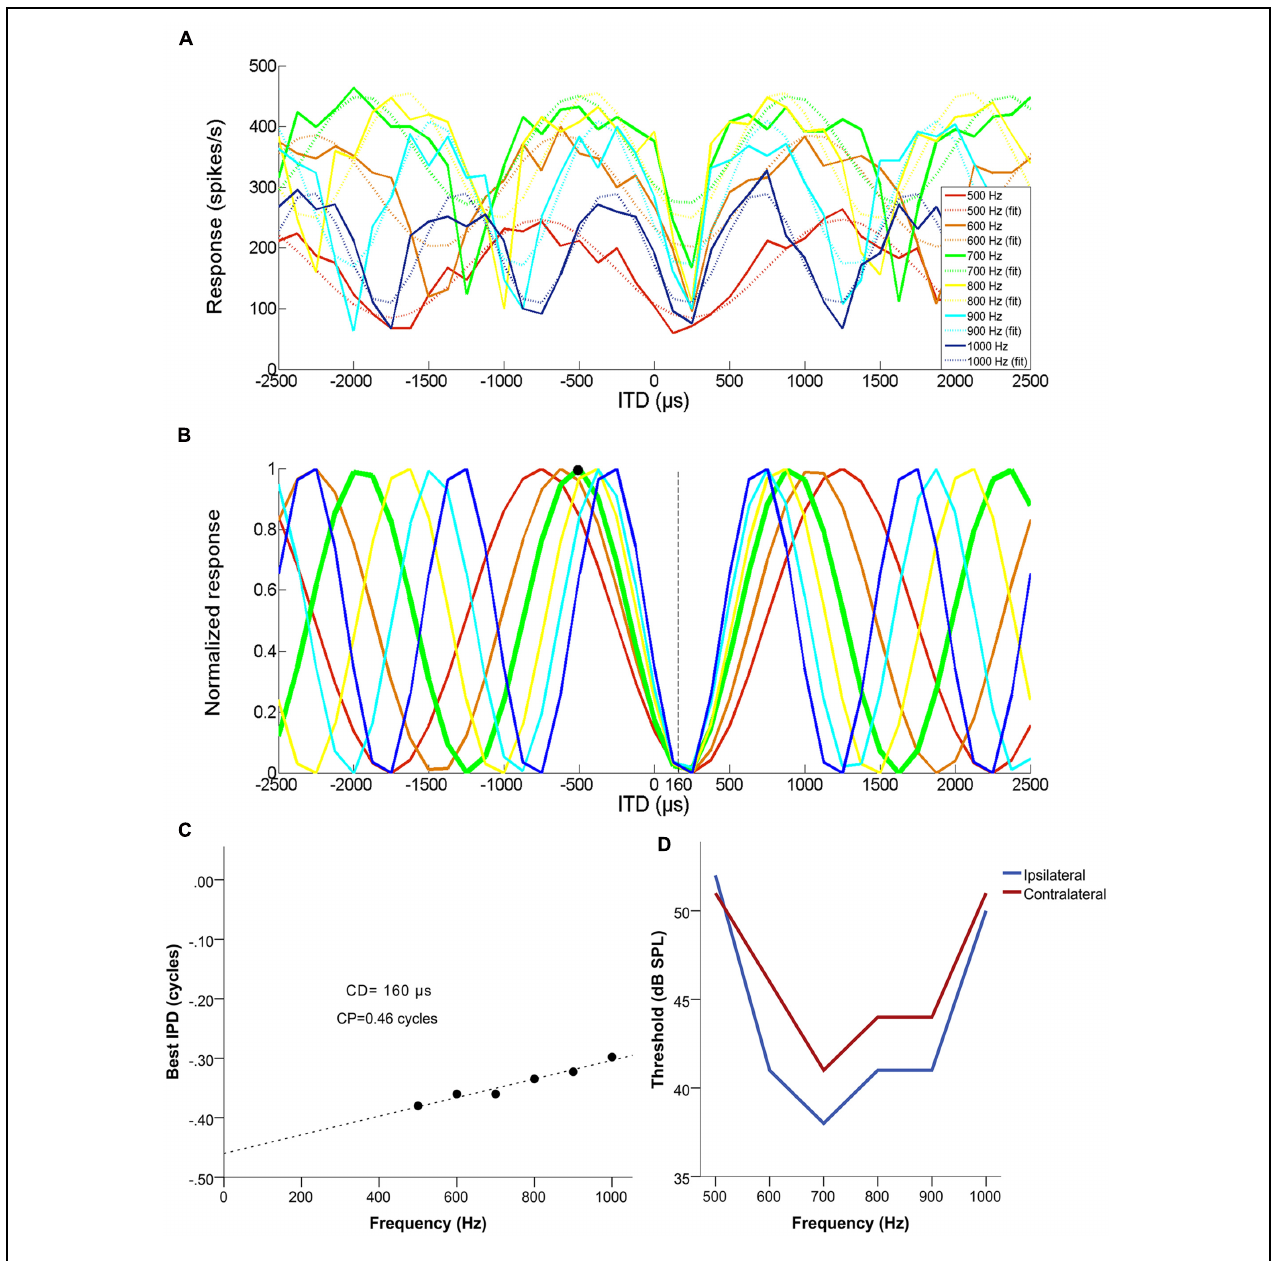
FIGURE 1 | Example of a set of multiple ITD curves used to determine the characteristic delay (CD) of a single unit with a BF of 700 Hz, a CD of 160 µ s contralateral-leading and a CP of 0.46. (A) Mean discharge rate as a function of ITD, for each of the tested frequencies (500–1000 Hz in 100 Hz steps). Dashed lines represent the cosine fit for each of the curves. (B) Normalized cosine fits in relation to the maximum response of each curve for